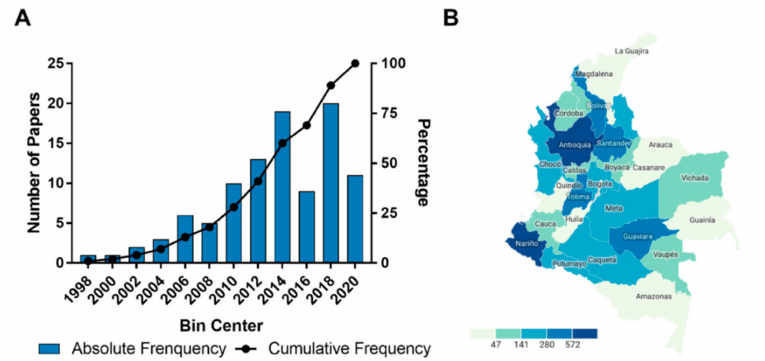
Figure 2. Evolution of the included scientific publications and geographical distribution of reported leishmaniasis cases in Colombia. ( A ) Time course of publications showing absolute (left-hand, y -axis) and cumulative frequency (right-hand, y -axis). ( B ) Number of reported cutaneous leishmaniasis (CL) cases for 2019 distributed through the political-administrative Colombian regions [39].